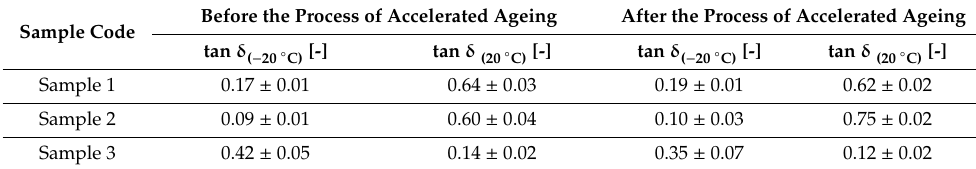
Table 5. Mechanical loss factor (tan δ ) of the material system samples.